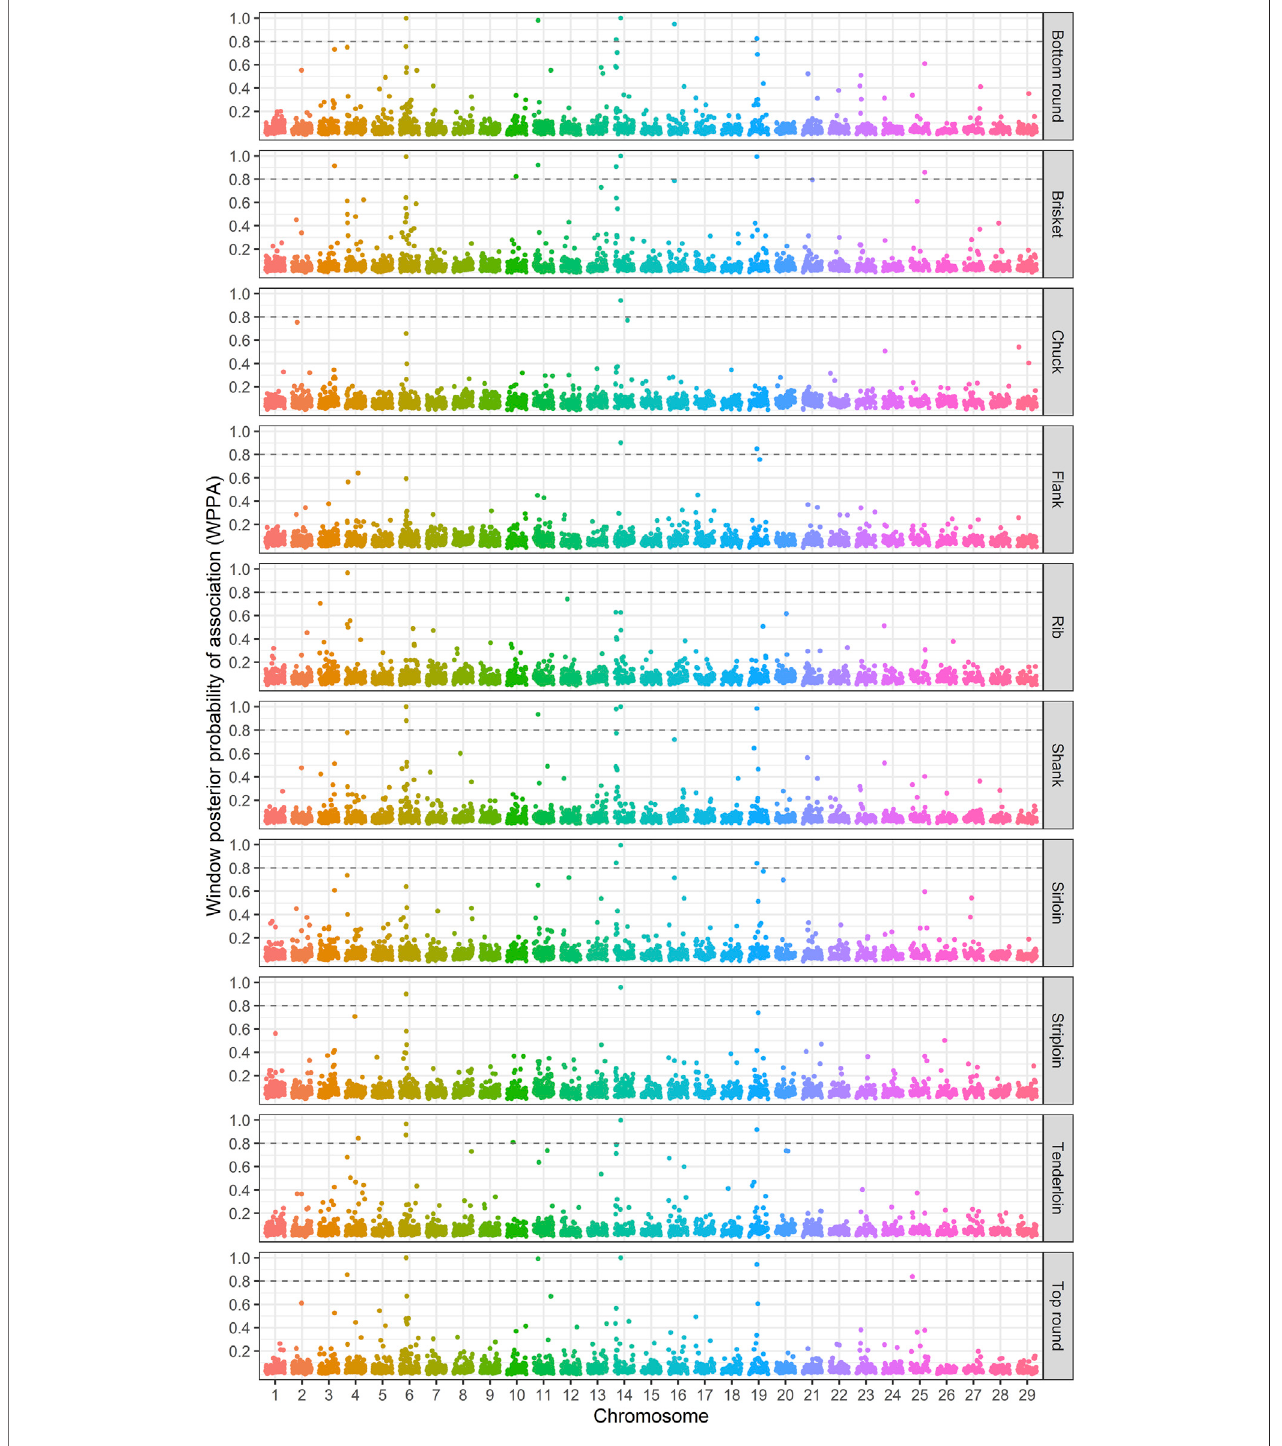
FIGURE 2 | Plots of window posterior probabilities of association (WPPA) obtained by the single-step Bayesian regression method for primal cut traits in Hanwoo cattle. The dash line is threshold 0.8 for signi fi cantly of windows.